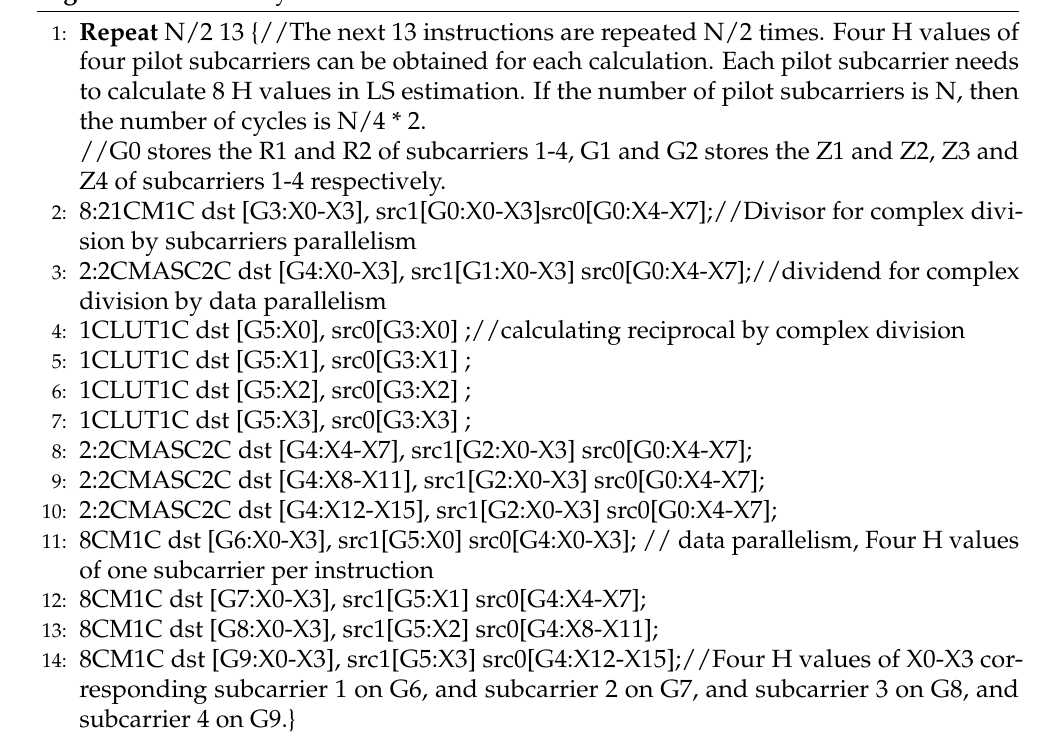
Algorithm 3 Assemblyinstruction code for LS